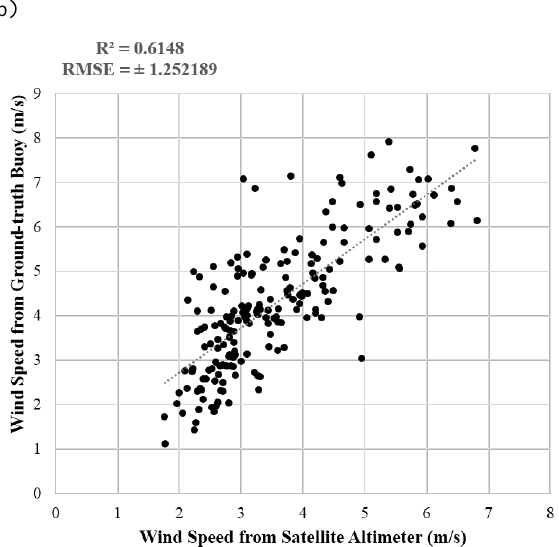
Figure 6. Correlation graph for point located at Sabah Sea (a) and Sarawak Sea